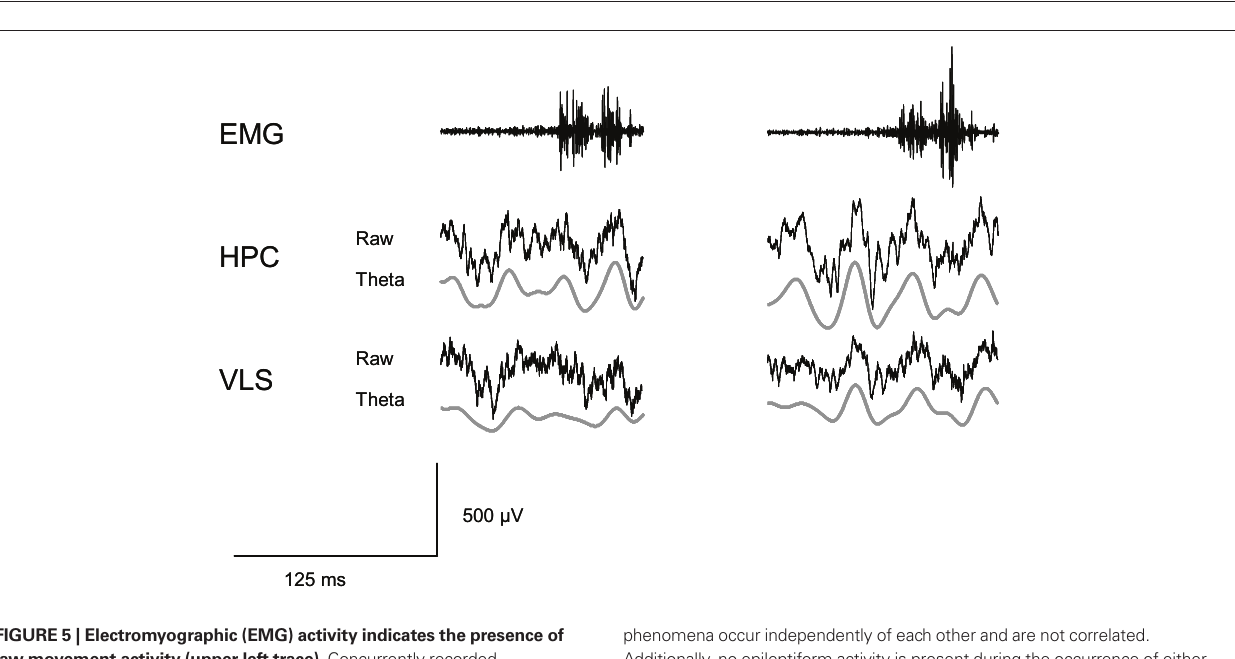
Figure 4 | Ventrolateral neostriatal LFP signal (Left: top trace in each pair) and eMg (Left: bottom trace in each pair) with and without rhythmic eMg activity (temporalis muscle) in behaving-rat following 0.5 mg pilocarpine. Traces were recording 10–15 min following treatment. Power spectral density (right) of 2-s traces